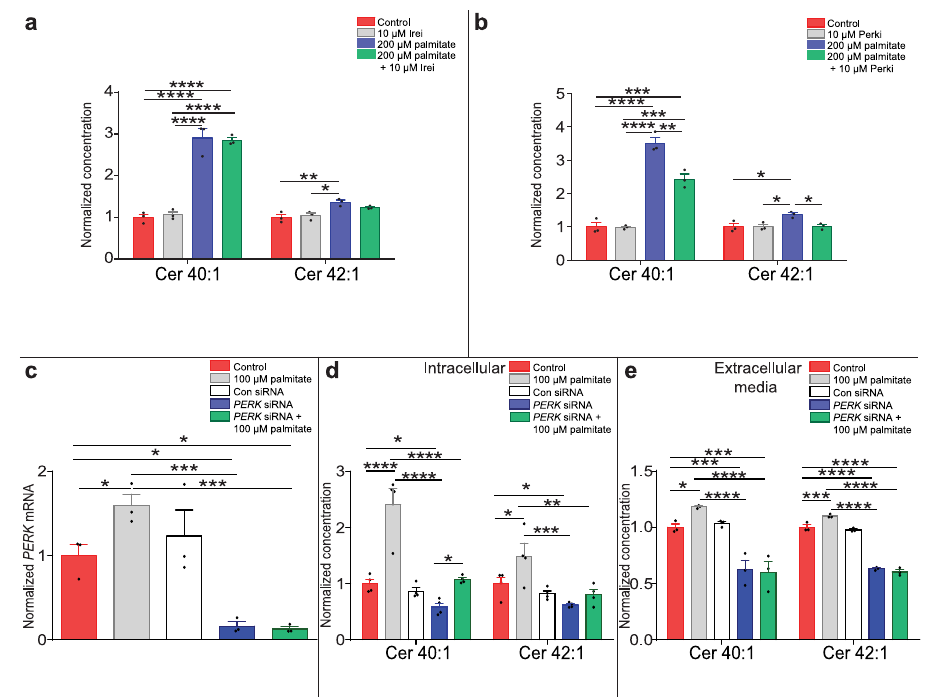
Fig. 5 Palmitate-induced long-chain ceramide synthesis requires Perk. a Ceramides (Cer) in C2C12 myotubes treated with palmitate or Bovine Serum Albumin (BSA), in combination with 10 µ M 4 µ 8c, an inhibitor of Ire1 (Ire1i) (control = red, Ire1i = grey, palmitate = blue, palmitate + Ire1i = green) ( n = 3; one-way ANOVA; control vs 200 µ M palmitate Cer 40:1 P < 0.0001, Cer 42:1 P = 0.0062; control vs 200 µ M palmitate + 10 µ M Ire1i Cer 40:1 P < 0.0001; 10 µ M Ire1i vs 200 µ M palmitate Cer 40:1 P < 0.0001, Cer 42:1 P = 0.013; 10 µ M Ire1i vs 200 µ M palmitate + 10 µ M Ire1i Cer 40:1 P < 0.0001). b Ceramides in C2C12 myotubes treated with palmitate or BSA, in combination with 10 µ M AMG PERK 44, an inhibitor of PERK (Perki) (control = red, Perki = grey, palmitate = blue, palmitate + Perki = green) ( n = 3; one-way ANOVA; control vs 200 µ M palmitate Cer 40:1 P < 0.0001, Cer 42:1 P = 0.022; control vs 200 µ M palmitate + 10 µ M Perki Cer 40:1 P = 0.0003; 10 µ M Perki vs 200 µ M palmitate Cer 40:1 P < 0.0001, Cer 42:1 P = 0.023; 10 µ M Perki vs 200 µ M palmitate + 10 µ M Perki Cer 40:1 P = 0.0002; 200 µ M palmitate vs 200 µ M palmitate + 10 µ M Perki Cer 40:1 P = 0.0017, Cer 42:1 P = 0.028). c PERK expression in control HSkMCs (red) and HSkMCs treated with 100 µ M palmitate (grey), scrambled control siRNA (con siRNA; white), siRNA against PERK ( PERK siRNA; blue) or PERK siRNA and 100 µ M palmitate (green) (n = 3; one-way ANOVA; control vs 100 µ M palmitate P = 0.05; control vs PERK siRNA P = 0.016; control vs PERK siRNA + 100 µ M palmitate P = 0.016; 100 µ M palmitate vs PERK siRNA P = 0.0004; 100 µ M palmitate vs PERK siRNA + 100 µ M palmitate P = 0.0004). d Cer 40:1 and Cer 42:1 normalised concentration in control HSkMCs (red) and HSkMCs treated with 100 µ M palmitate (grey), con siRNA (white), PERK siRNA (blue) or PERK siRNA and 100 µ M palmitate (green) ( n = 4; one-way ANOVA; control vs 100 µ M palmitate, Cer 40:1 P < 0.0001, Cer 42:1 P = 0.015; control vs PERK siRNA Cer 40:1 P = 0.05, Cer 42:1 P = 0.05; 100 µ M palmitate vs PERK siRNA Cer 40:1 P < 0.0001, Cer 42:1 P = 0.0002; 100 µ M palmitate vs PERK siRNA + 100 µ M palmitate Cer 40:1 P < 0.0001, Cer 42:1 P = 0.0015; PERK siRNA vs PERK siRNA + 100 µ M palmitate Cer 40:1 P = 0.0262). e Cer 40:1 and Cer 42:1 normalised concentration in media conditioned on control HSkMCs (red) and HSkMCs treated with 100 µ M palmitate (grey), con siRNA (white), PERK siRNA (blue) or PERK siRNA and 100 µ M palmitate (green) ( n = 3; one-way ANOVA; control vs 100 µ M palmitate, Cer 40:1 P = 0.0487, Cer 42:1 P = 0.0007; control vs PERK siRNA Cer 40:1 P = 0.0009, Cer 42:1 P < 0.0001; control vs PERK siRNA + 100 µ M palmitate, Cer 40:1 P = 0.0006, Cer 42:1 P < 0.0001; 100 µ M palmitate vs PERK siRNA Cer 40:1 P < 0.0001, Cer 42:1 P < 0.0001; 100 µ M palmitate vs PERK siRNA + 100 µ M palmitate Cer 40:1 P < 0.0001, Cer 42:1 P < 0.0001). * P ≤ 0.05, ** P < 0.01, *** P < 0.001, **** P < 0.0001. Data are expressed as mean ± SEM with individual data points. Source data are provided as a Source Data fi cell. Similar effects on intracellular ceramide 40:1 and 42:1, and dihydroceramide 40:0 and 42:0 were seen in long-chain ceramide- treated primary HSkMCs (Fig. 8c, d).